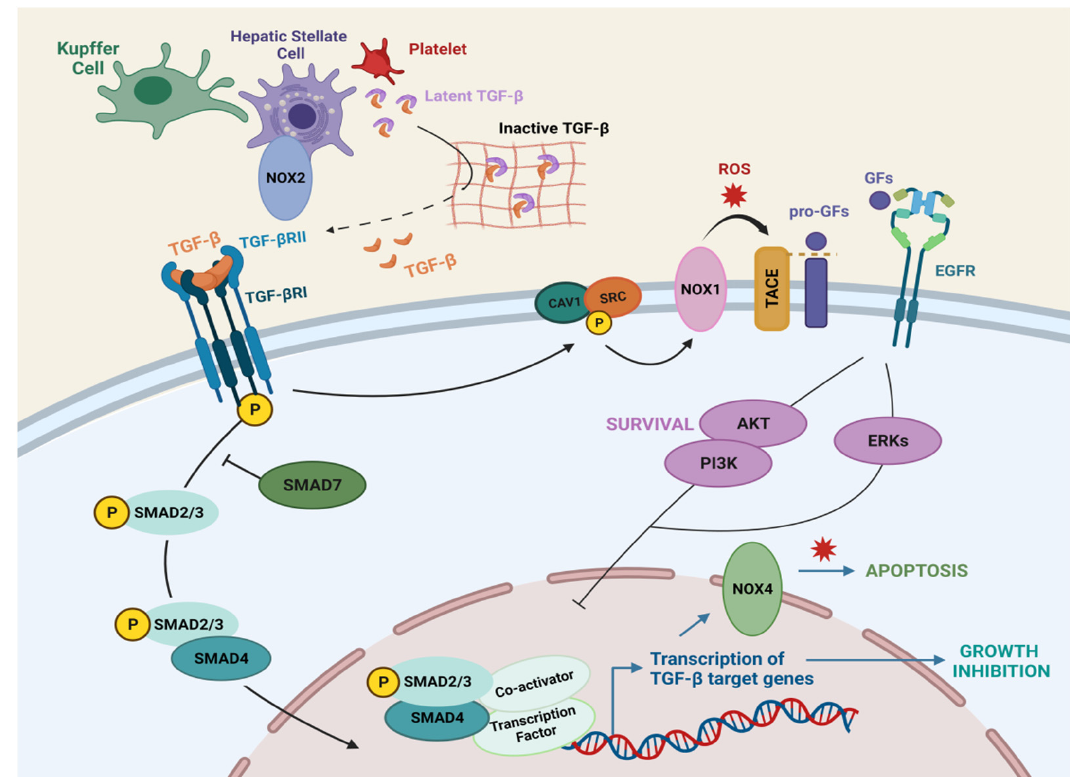
Figure 3. TGF- β signaling in liver cells. TGF- β is synthesized by hepatic stellate cells, kupffer cells and platelets, and anchored to the ECM in a latent form. Once active, TGF- β binds TGF β RII, which recruits TGF β RI, inducing Smad phosphorylation and nuclear translocation, where transcription of target genes occurs. TGF- β -induced shedding of the EGF family of growth factors requires the activation of TACE/ADAM17 in a Caveolin-1/Src/NOX1 dependent manner. Figure was created with BioRender.com (accessed on 20 July 2021).